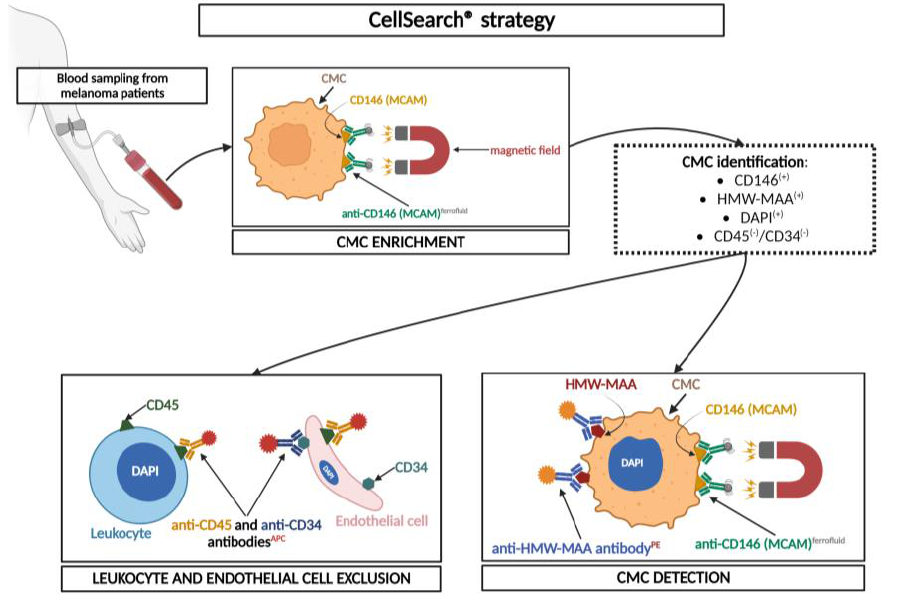
Figure 2. Principle of CellSearch ® strategy in patients with melanoma. The procedure was based on enrichment and detection steps. The positive CMC enrichment was based on the expression of CD146 by melanoma cells. Secondarily, CMC detection was based on the expression of the HMW- MAA and positive signals from the nucleus (stained with DAPI). Leukocytes and endothelial cells were excluded based on CD45 and CD34 marker expression (respectively). Abbreviations: MCAM, melanoma cell adhesion molecule; HMW-MAA, high molecular weight; PE, phycoerythrin; APC, allophycocyanin; DAPI, 4′,6 -diamidino-2-phenylindole. Created with Biorender.com (accessed on 20 December 2022).